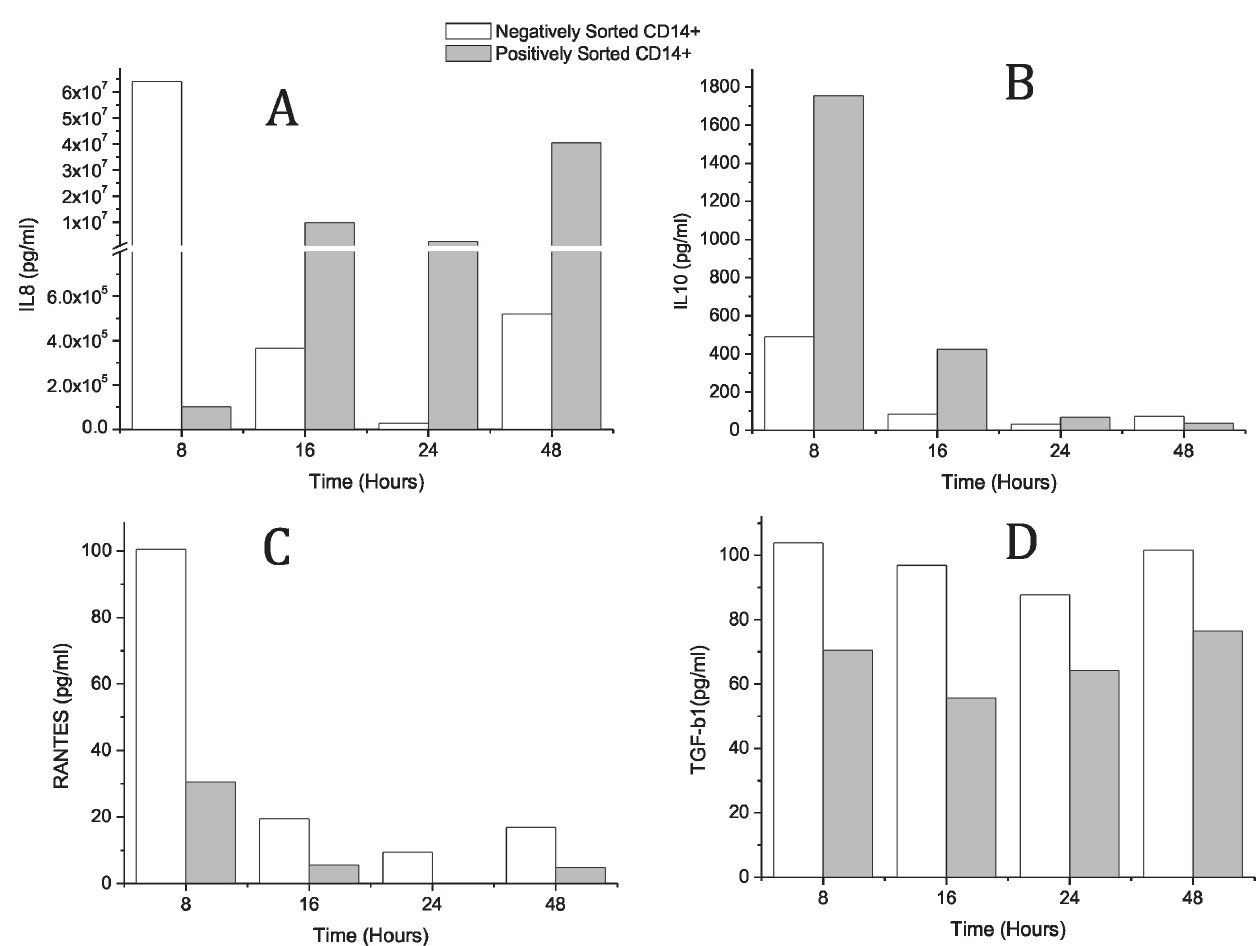
Figure 1. The levels of IL-8, IL-10, TGF- β 1 and RANTES in 5 pooled samples at different time points after positively and negatively isolated CD14+ monocytes were stimulated with